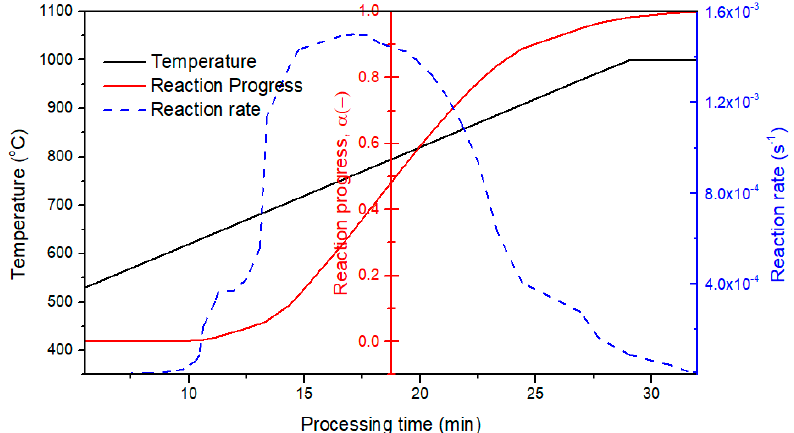
Figure 8. Kinetic prediction activation energy and modified reaction constant (A α f( α )) of reaction step 3 as a function of reaction progress α .